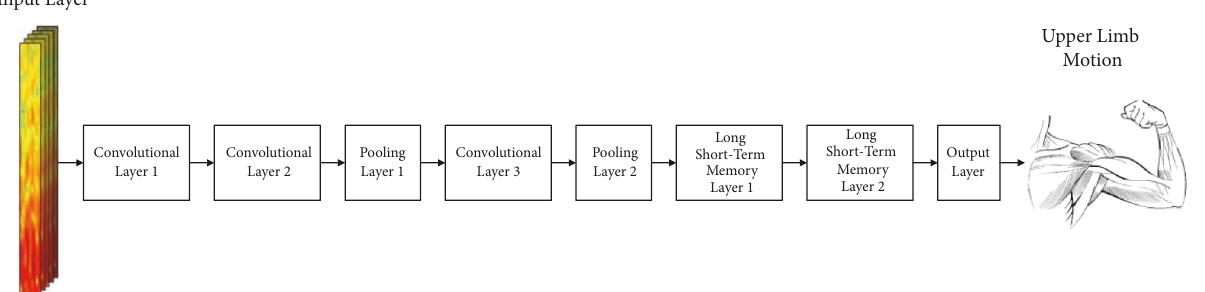
Figure 6: The architecture of the recurrent convolutional neural network (RCNN) model